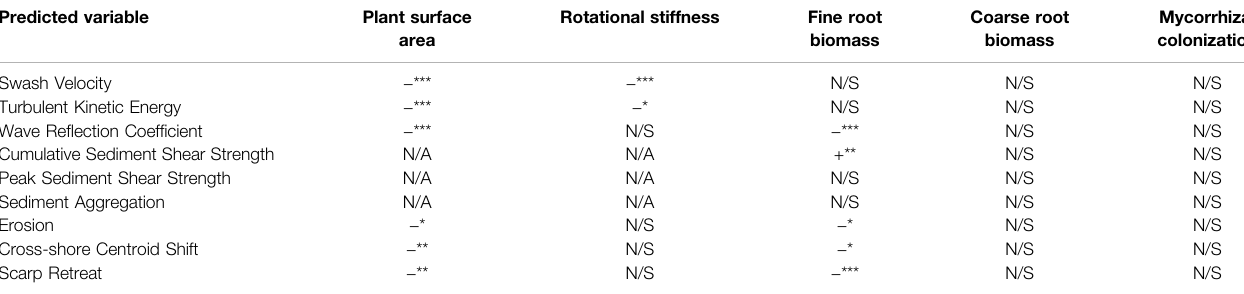
TABLE 3 | Summary of all multivariate models.